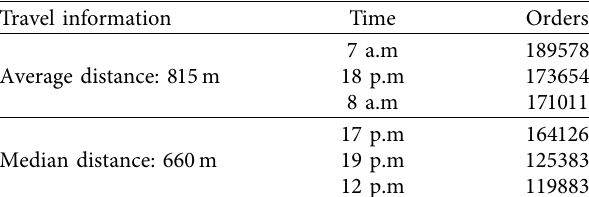
Table 3: Examples of user travel